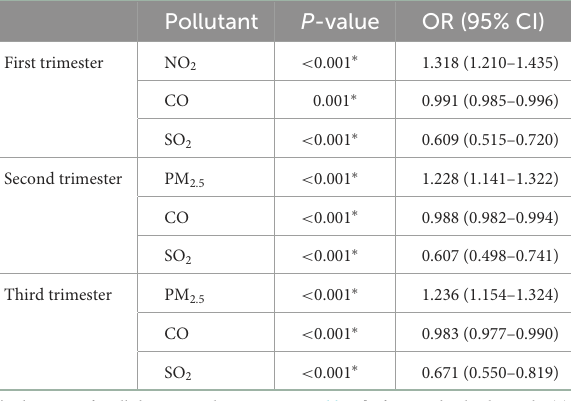
∗ Adjustment for all the potential covariates in Table2 [infant gender, birth weight (g), number of pregnancies, maternal age] and for the effects of other air pollutants in the